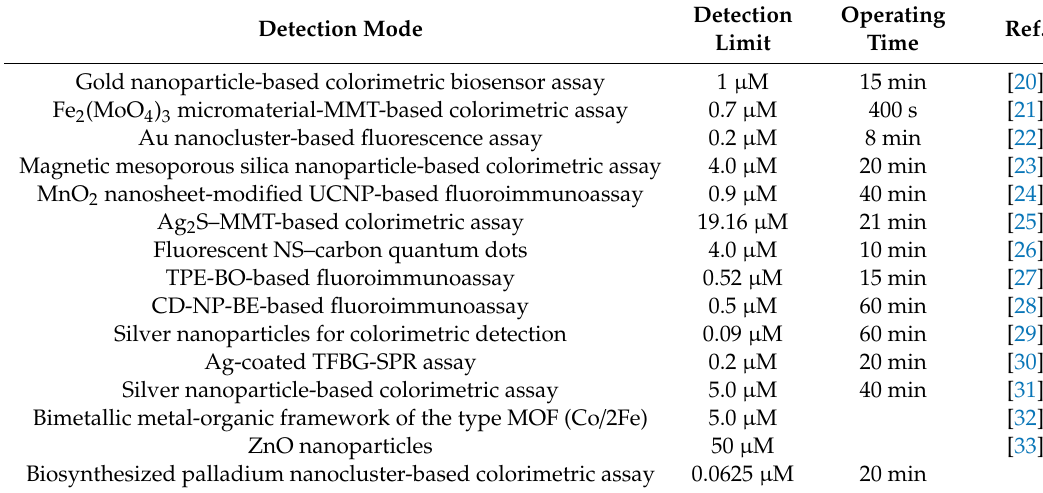
Table 1. Comparison of various reported methods for H 2 O 2